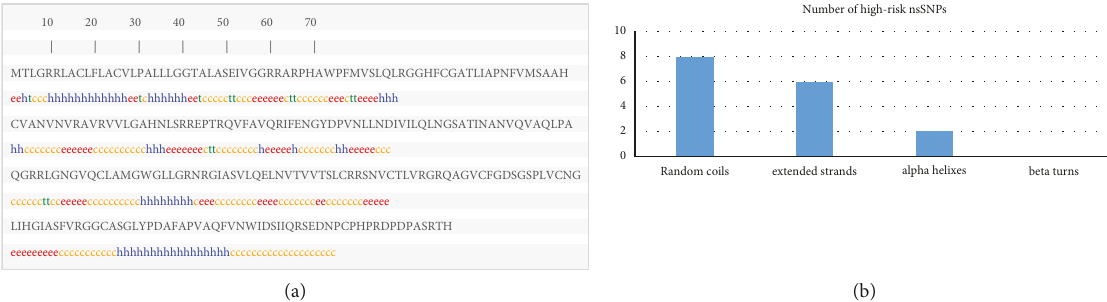
Figure 7: (a) SOPMA predicted distribution of high-risk ELANE nsSNPs in random coils, alpha-helices, extended strand, and beta-turns. (b) SOPMA study of the secondary structure of individual amino acid residues in ELANE gene-derived protein. The high-risk nsSNPs are indicated by the